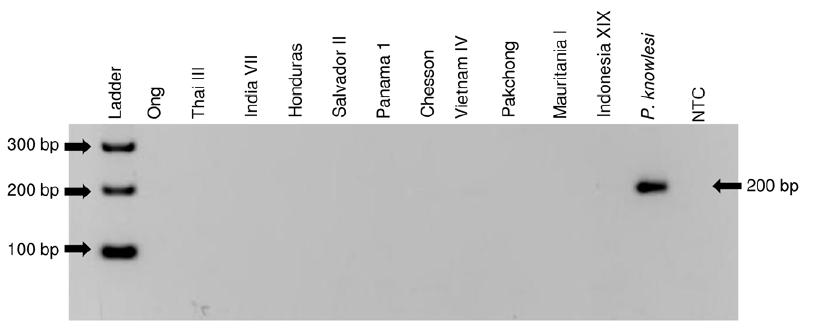
Figure 4. Primer set Pkr140-5 does not cross react with P.vivax . Multiple P. vivax strains were tested using primer set Pkr140-5 (expected size 200bp) in order to test the primers’ specificity. NTC=No template control.